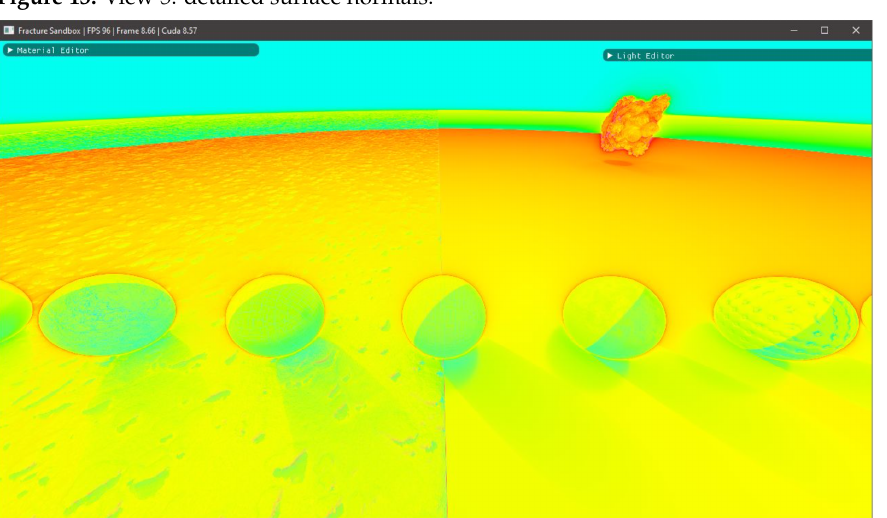
Figure 13. View 5: detailed surface normals.